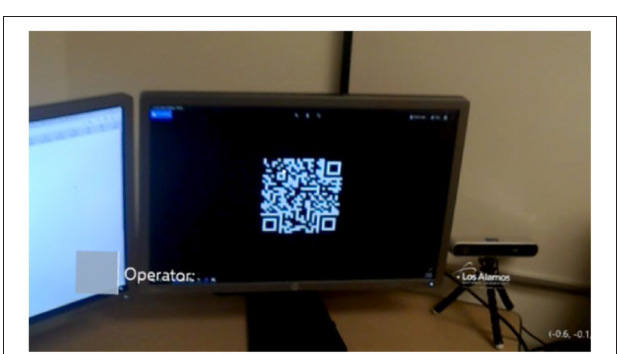
FIGURE 25 | The operator first anchors their initial position and pose by gazing at a QR code.